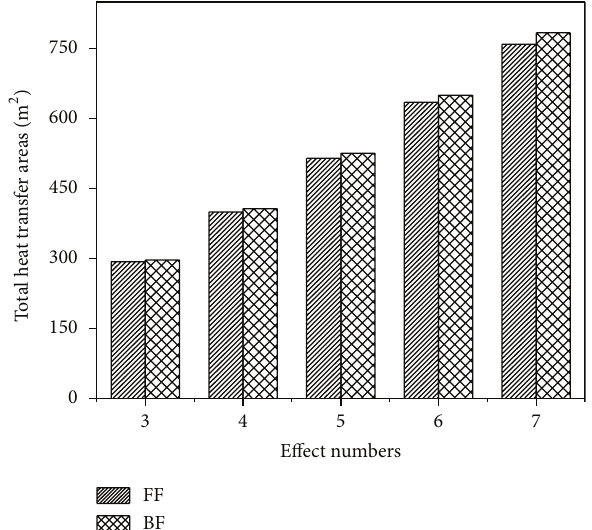
Figure9:ComparisonoftotalheattransferareasbetweenFFsystem and BF